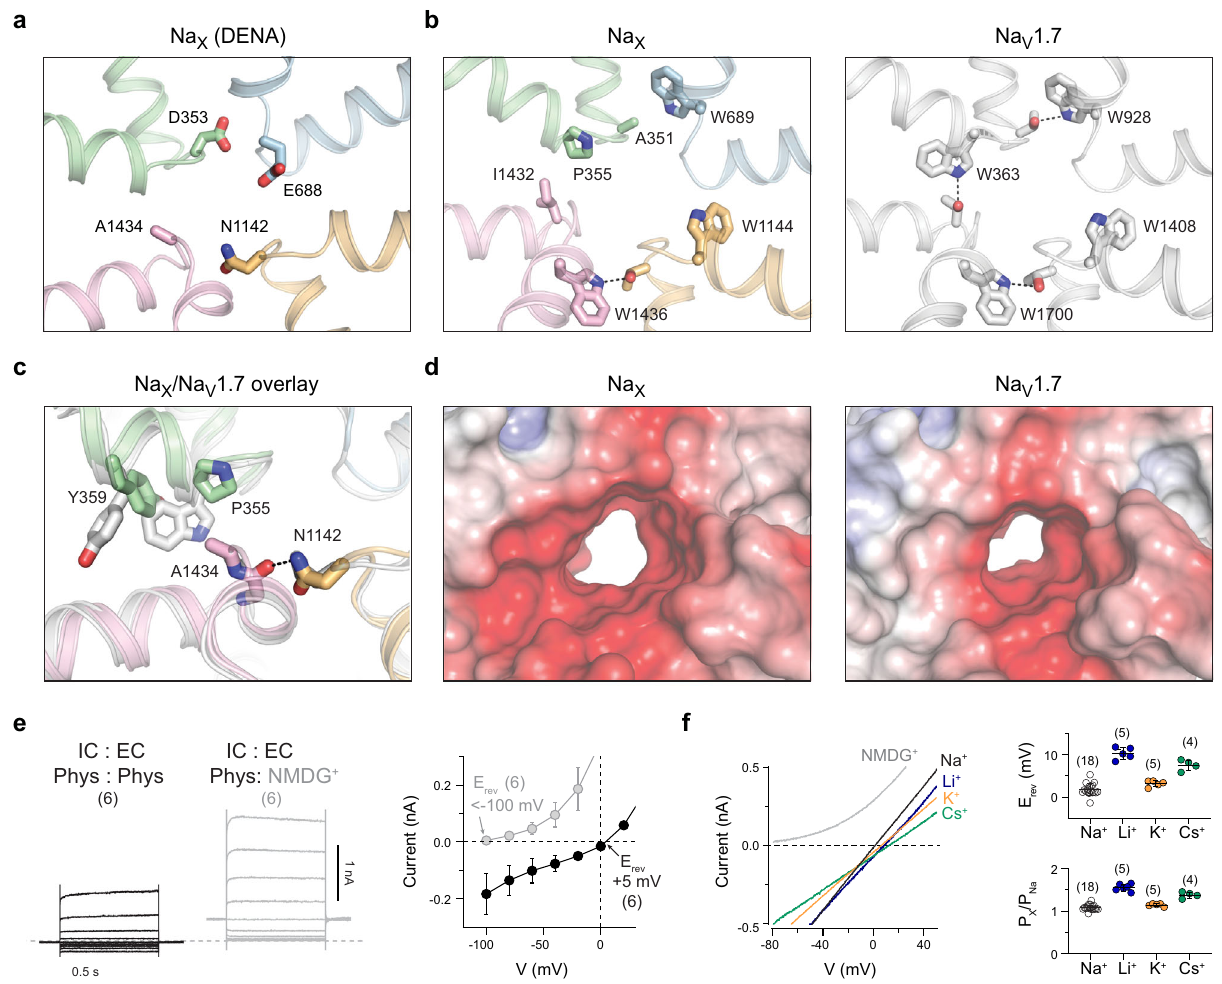
Fig. 3 Structure and characterization of the Na X selectivity fi lter. a Na X DENA-motif side-chains shown as sticks. b Residues in Na X that form a conserved interaction network around the selectivity fi lter in Na V channels (Na V 1.7, PDB 6J8J). c Superimposed view of the DI-DIV interface comparing Na X and Na V 1.7 (gray, PDB 6J8J). d View as in b , Na X and Na V 1.7 selectivity fi lter electrostatic surface rending. Note, central cavity and activation gate excluded for clarity. e Representative currents from HEK293T cells expressing human Na X -QTT with a C-terminal GFP-Flag tag in a physiological (left) or NMDG + -only extracellular solution (middle). See methods for composition of intracellular (IC) and extracellular (EC) solutions. Steps between + 80 to −